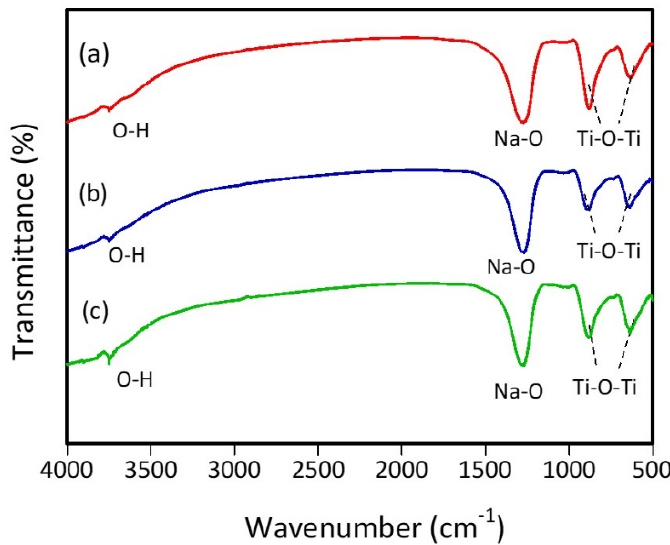
Figure 6. Infrared spectra of ( a ) 1% Au/TiO 2 /NTO, ( b ) 2% Au/TiO 2 /NTO, and ( c ) 3% Au/TiO 2 /NTO.